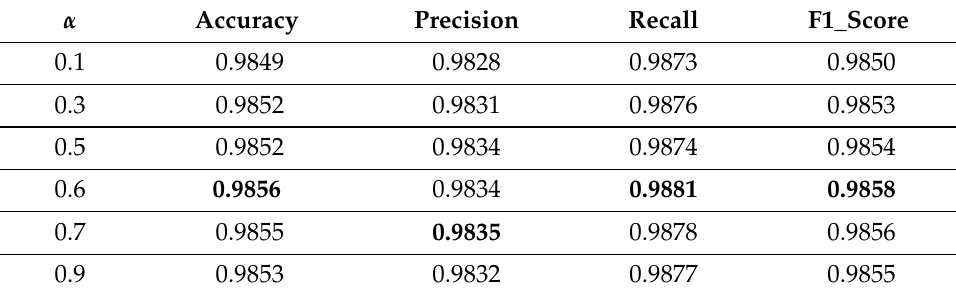
Table A1. Detection performance under different “alpha”